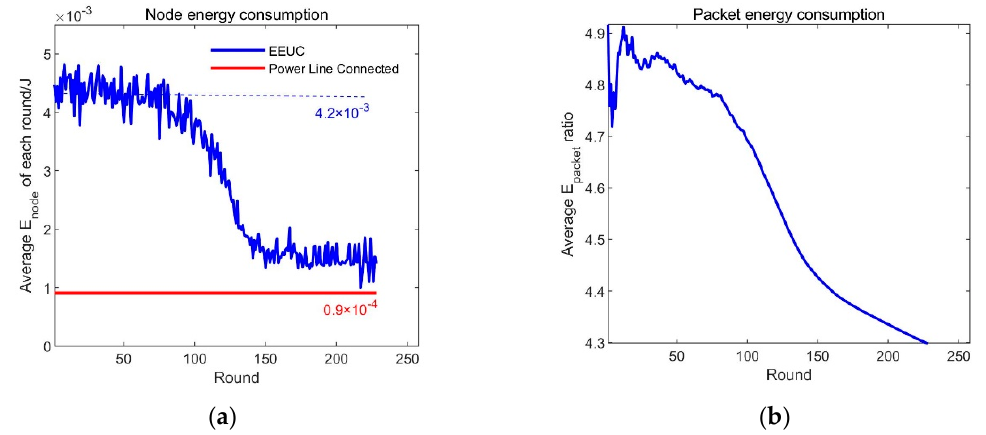
Figure 12. Node energy consumption and packet energy consumption ( a ) Node average energy consumption for each round, ( b ) Packet average energy consumption ratio.